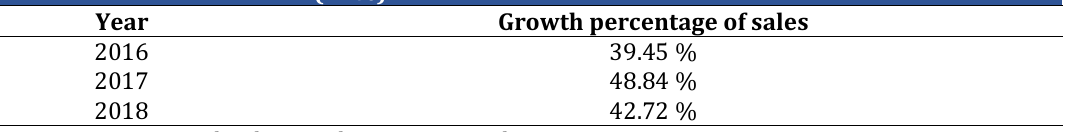
Table 2: Sales Growth Data (in %) Make Over for